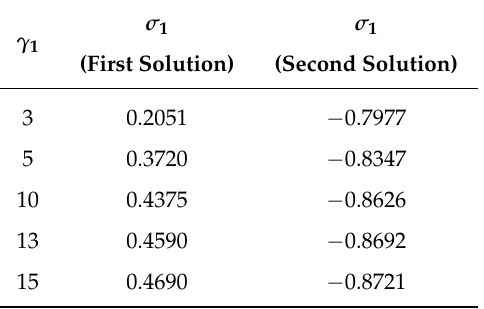
Table 2. σ 1 for diverse γ 1 when γ 2 = 5, Le = 1, Nb = Nt = 0.2, M = 0.5, Pr = 1 and λ = −